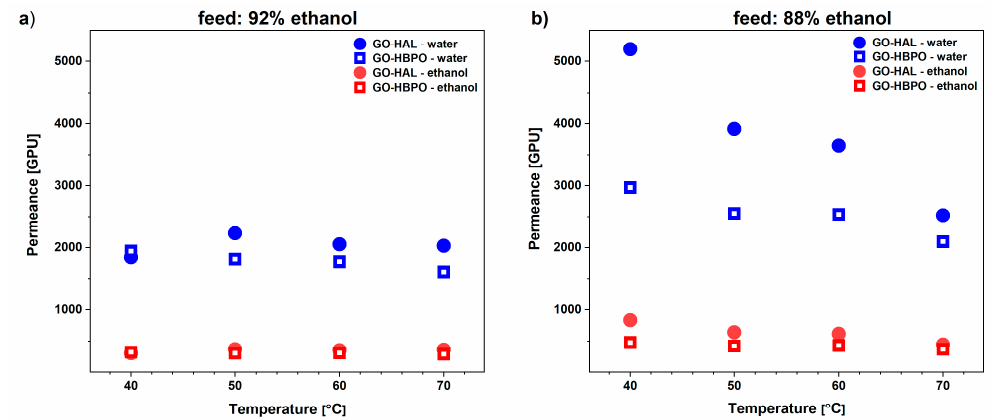
Figure 4. Permeance of water (blue symbols) and ethanol (red symbols) components at four operating temperatures for GO-HAL and GO-HBPO membranes for ethanol / water feeds with ( a ) 92% and ( b ) 88% ethanol. The permeance values have been expressed in Gas Permeation Units (GPUs), where 1 GPU = 3.35 × 10 − 10 mol · (m 2 · s · Pa) − 1